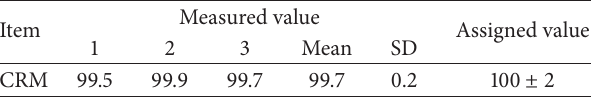
Table 8: Verification results of chloramphenicol in methanol CRM (unit: